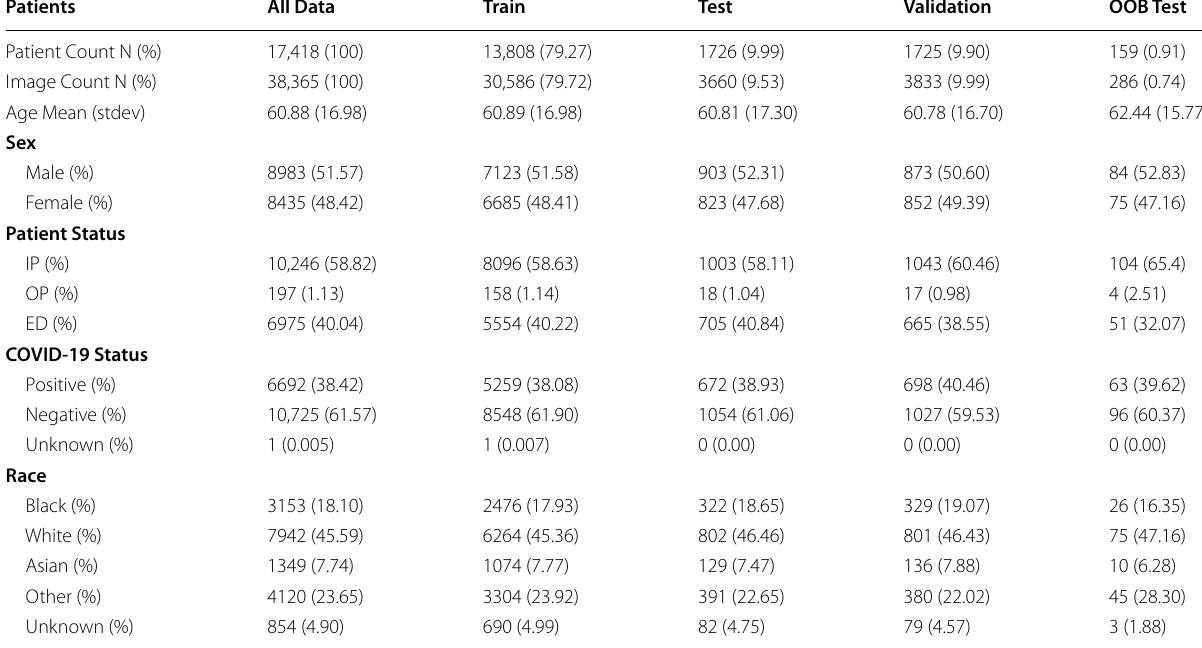
Patient-wise demographics for age, sex, patient status, COVID-19 status, and race.